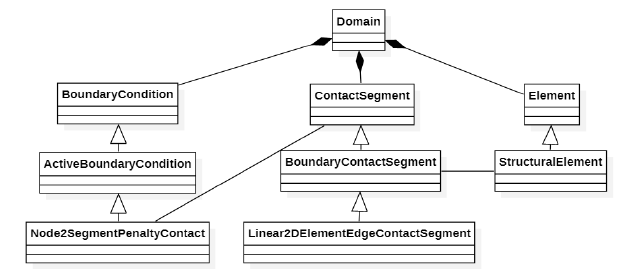
Figure 1. A UML diagram describing the concept of object relationships within